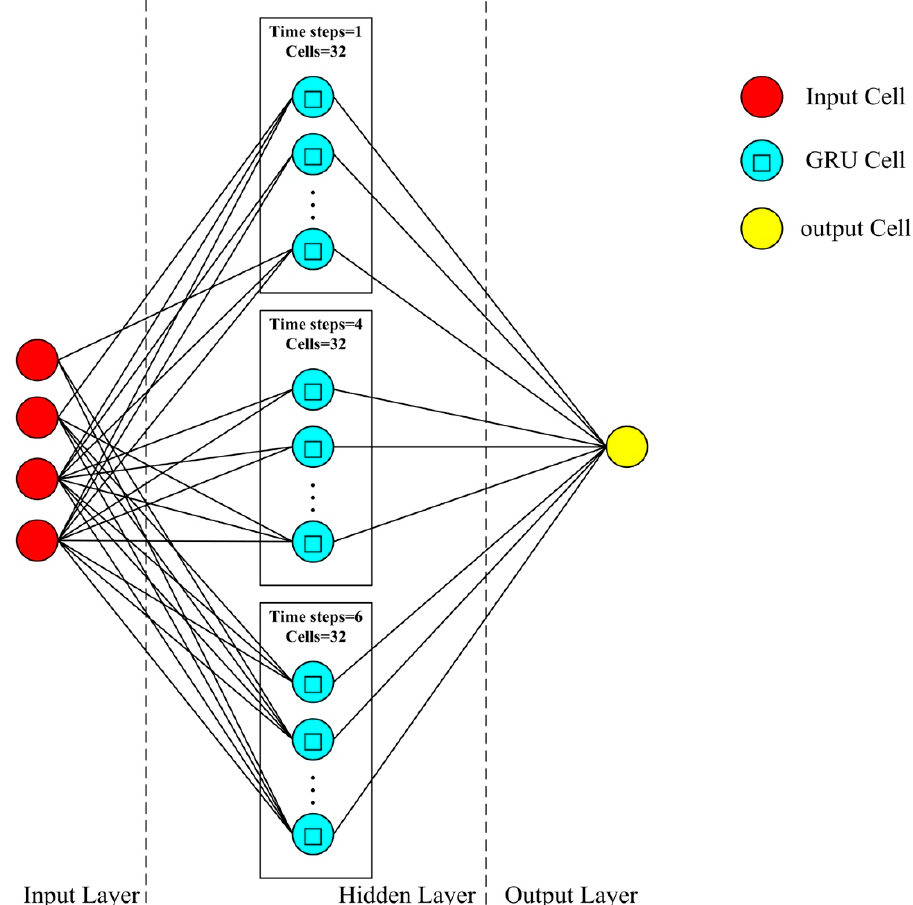
Figure 2. The structure of GRU neural network.